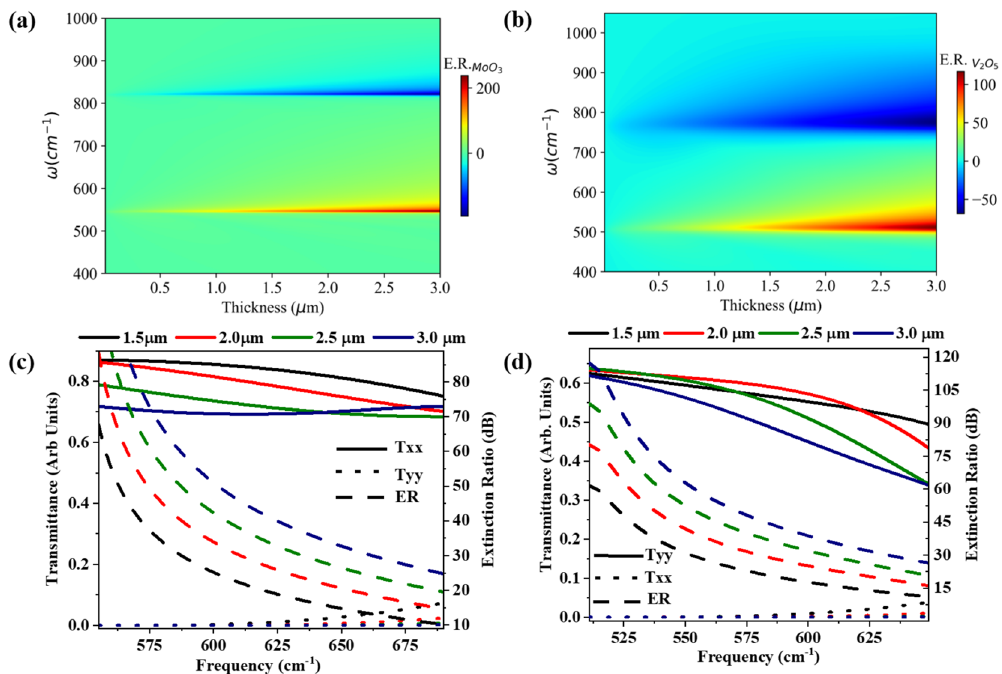
Figure 4. Extinction ratio (in dB) of ( a ) α - MoO 3 and ( b ) α - V 2 O 5 based mid-IR polarizer as a function of thickness and frequency. At different thicknesses, figures of merit (i.e. transmission efficiencies and ER) of ( c ) α - MoO 3 and ( d ) α - V 2 O 5 based